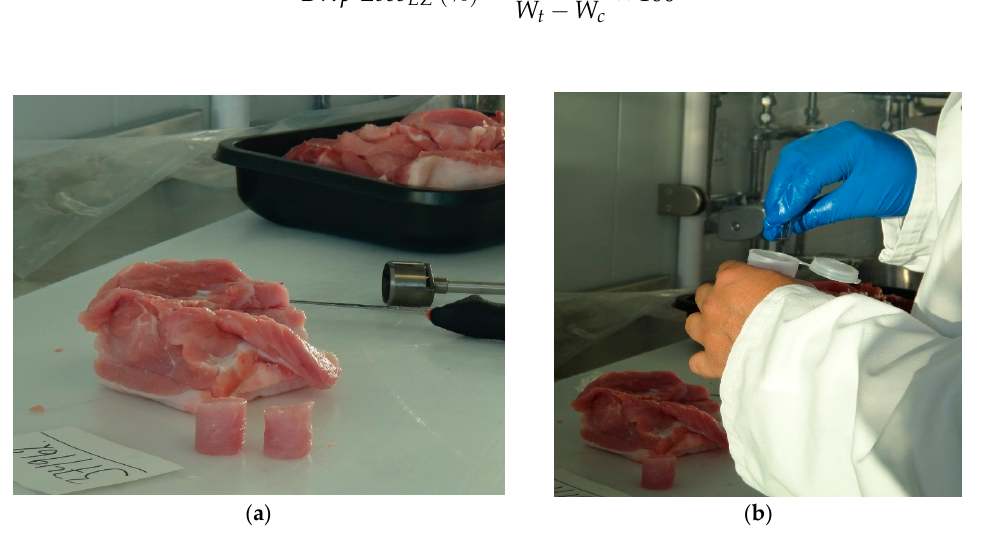
Figure 4. ( a ) Preparation of the 25 mm diameter core samples from the 20 mm thick slice of loin; and ( b ) placement of a sample in an EZ-Driploss container.